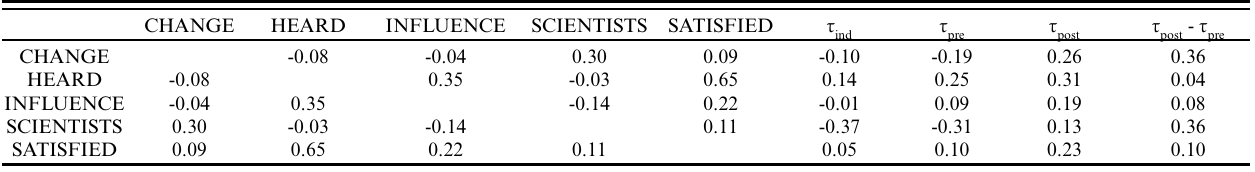
, τ , τ , τ - τ . Labels are defined in Fig. 4 and in the ind pre post post pre